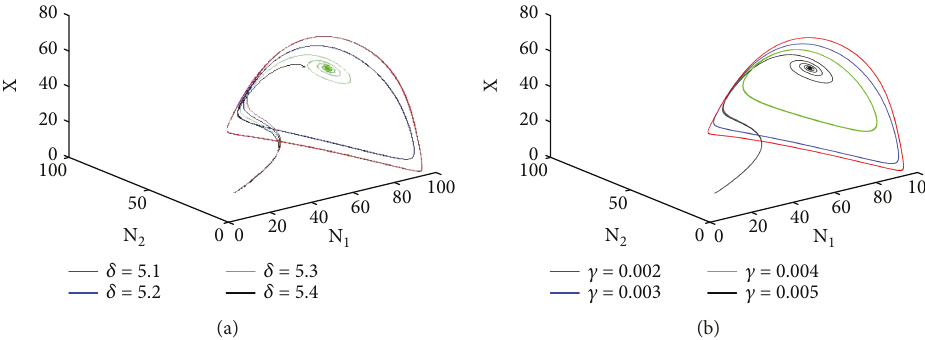
Figure 8: Phaseplot diagram of nondelayed model system (1) for di ff erent(a) δ and (b) γ . The restof the parametersaretaken as given in the